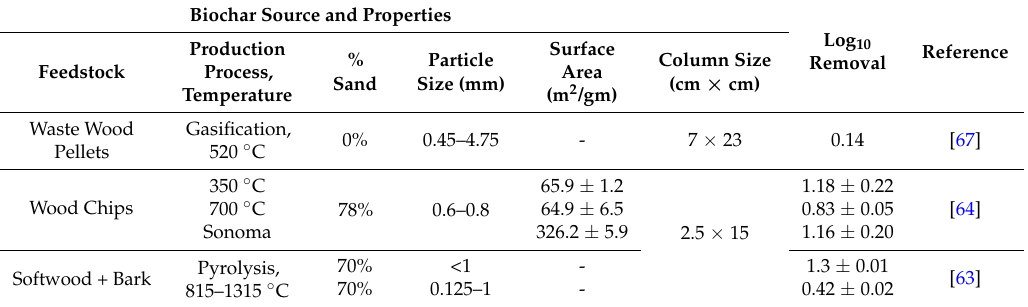
Table 3. Removal of E. coli in sand stormwater biofilters amended with